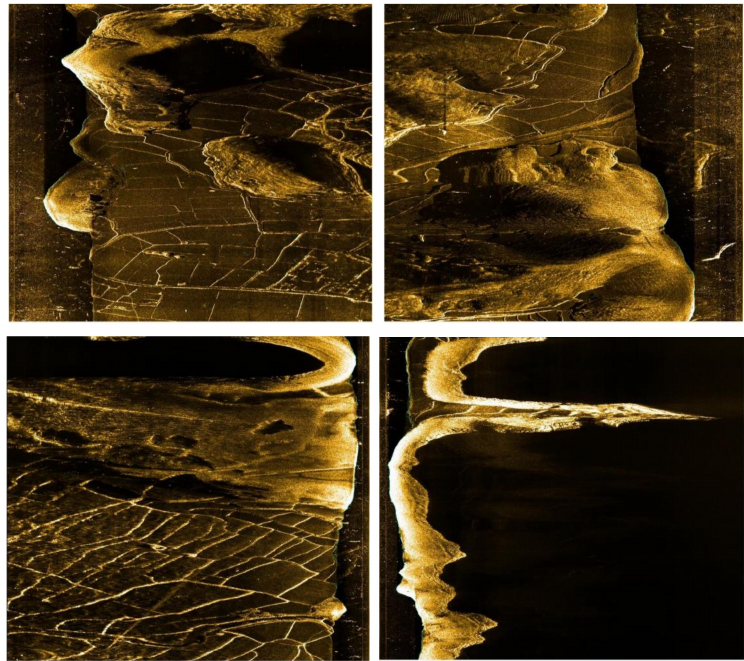
Figure 5. The original sonar image (each sonar image is cropped down the middle into two images).